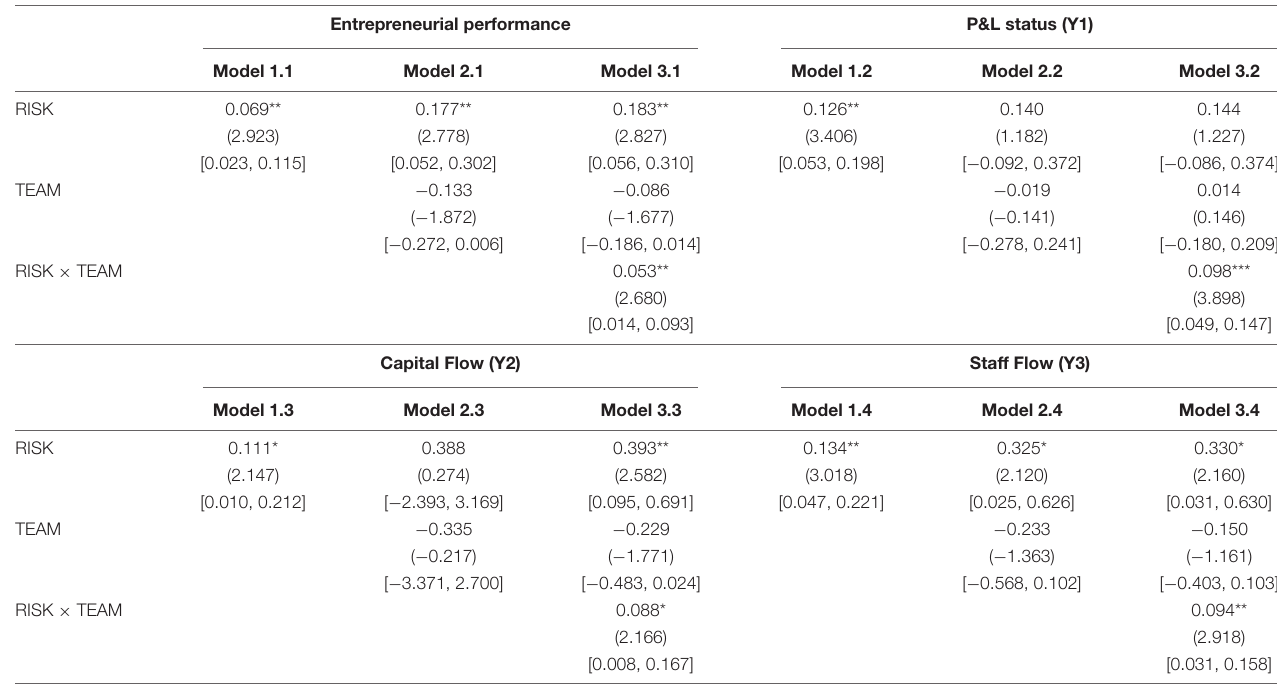
TABLE 4 | Results of